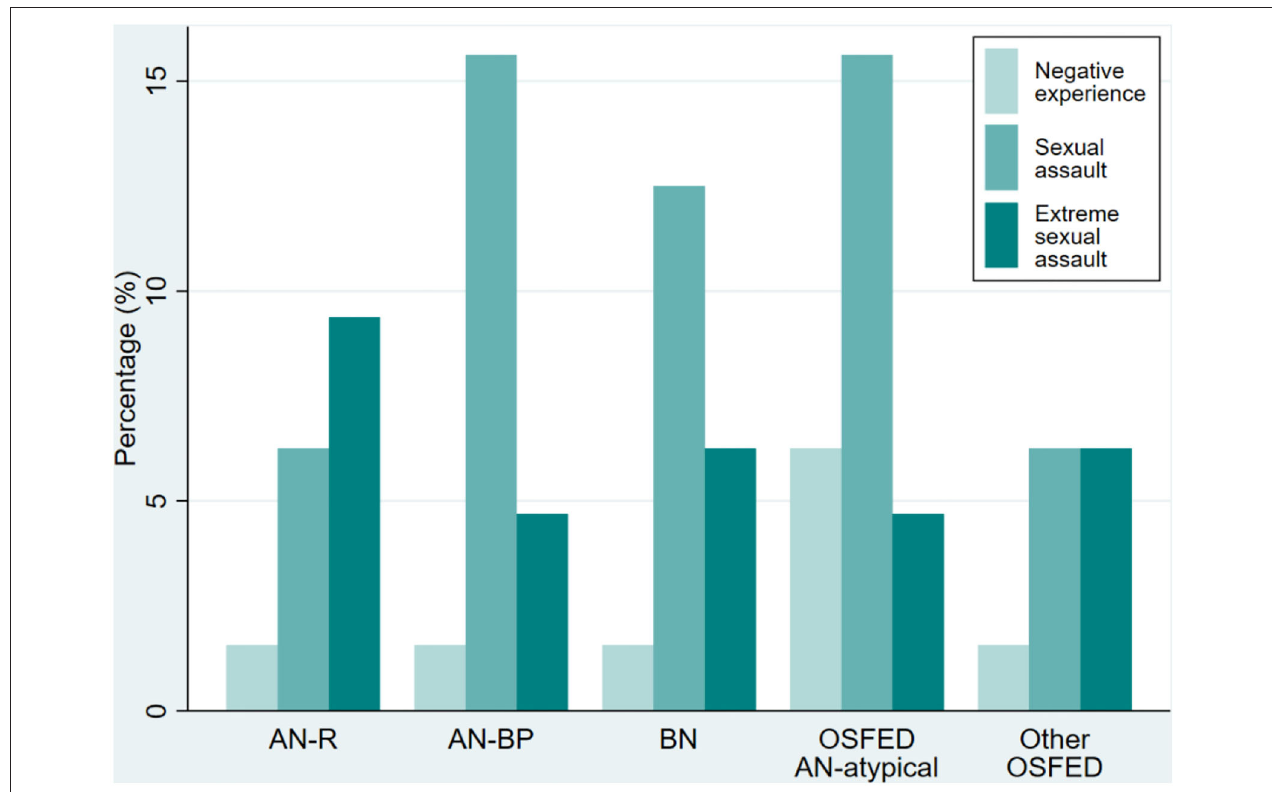
FIGURE 3 | Severity of STE by diagnostic category. Distribution of the severity of STE for each diagnostic category ( N = 329). Note that since far from all patients reported STE, the sum of the percentages in the bars for each diagnostic category does not add up to 100%.